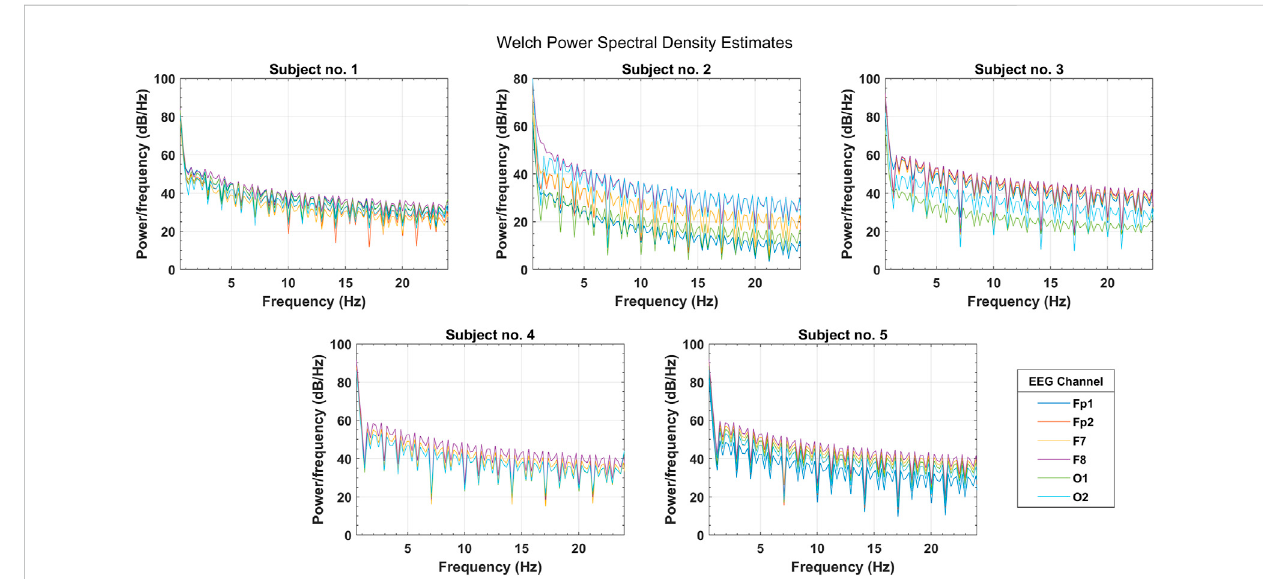
FIGURE 5 Welch ’ s power spectral density estimates for selected PFC, FC, and OC channels over the spectral range of four EEG bands (subjects 1 –